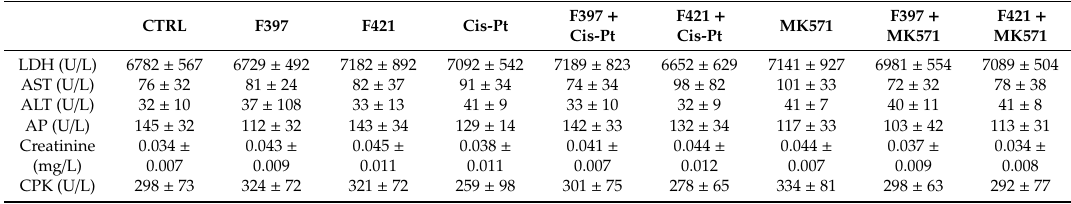
Table 2. Hemato-chemical parameters of